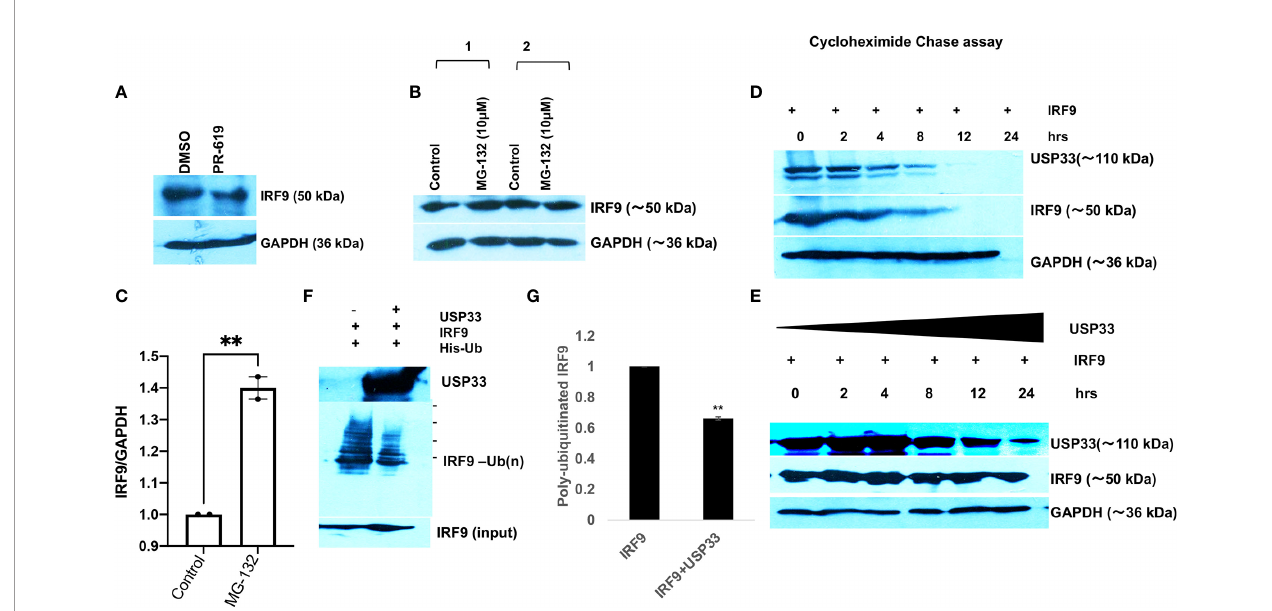
FIGURE 5 | USP33 regulates the IRF9 turnover via its deubiquitylation in microglia. (A) Immunoblot image showing the impact of deubiquitinase inhibitor PR-619 on the levels of IRF9 in microglial cells. PR-619 were treated at 10 µM fi nal concentration for 8 hours and cells were harvested and followed by western blot analysis. (B) Immunoblot images showing the impact of proteasome inhibitor MG-132 on the elevated stability of IRF9 in microglial cells. (C) Graph bar displaying the average increase in IRF9 levels upon MG-132 treated human microglial cells. (D) Immunoblot analysis of half-life of IRF9 protein measured via cycloheximide chase assay done in HEK-293T cells. (E) Immunoblot analysis of impact of USP33 on turnover of IRF9; measured via cycloheximide chase assay performed in HEK-293T cells. Cycloheximide chase assay have been repeated two times and representative results are displayed here. (F) Immunoblot image showing the impact of USP33 on polyubiquitinated levels of IRF9. 5µg of pLV-IRF9 plasmids and 5µg of 6X-His-ubiquitin plasmids were transfected along with 5µg of Flag-HA-USP33 in co- transfection experiments (in 60mm dish format) to check the impact of USP33 on ubiquitination levels of IRF9. After 24 hours, cells were treated with MG132 for 8 hours, followed by in vivo ubiquitination assay as described in detail in Material and Methods section. (G) The graph bars showing the quanti fi ed levels of poly- ubiquitinated IRF9. The ubiquitination assay was performed three times independently and average values are shown as graph bars. Data are displayed as mean and mean ± S.E.M. student ’ s t-test have been utilized to obtain the statistical signi fi cance, indicated as ** for p values